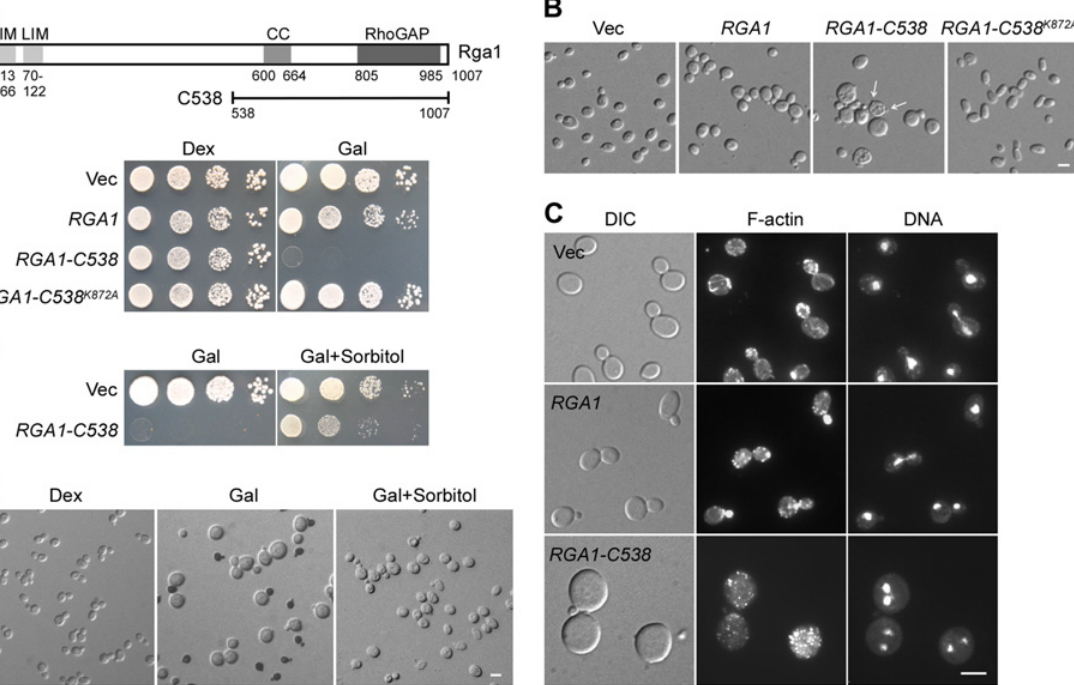
Fig 1. Phenotypes of yeast cells overexpressing Rga1-C538. (A) Cells of strain YEF473A carrying integrated pEGKT306 (Vec), pEGKT306-RGA1, pEGKT306-RGA1-C538, and pEGKT306-RGA1-C538 K872A plasmids were spotted on SC-Ura (Dex) and SRG-Ura (Gal) plates at 1:10 serial dilution and incubated at 30°C for 4 days. Upper panel, schematic representation of Rga1 and Rga1-C538 segement. CC, coiled-coil. (B) DIC images of cells as in (A) grown on SRG-Ura plate for 16 hr at 30°C. (C) F-actin and DNA staining of cells grown on SRG-Ura plate for 16 hr at 30°C. (D) YEF473A cells carrying pEGKT306 (Vec) and pEGKT306-RGA1-C538 plasmids were grown on SRG-Ura (Gal) and SRG-Ura+1 M Sorbitol plates at 30°C. Pictures were taken after 4 days. (E) Methylene blue staining of YEF473A cells carrying integrated pEGKT306-RGA1-C538 grown on SC-Ura, SRG-Ura and SRG-Ura+1 M Sorbitol plates for 12 hr at 30°C. Bars, 5 μ